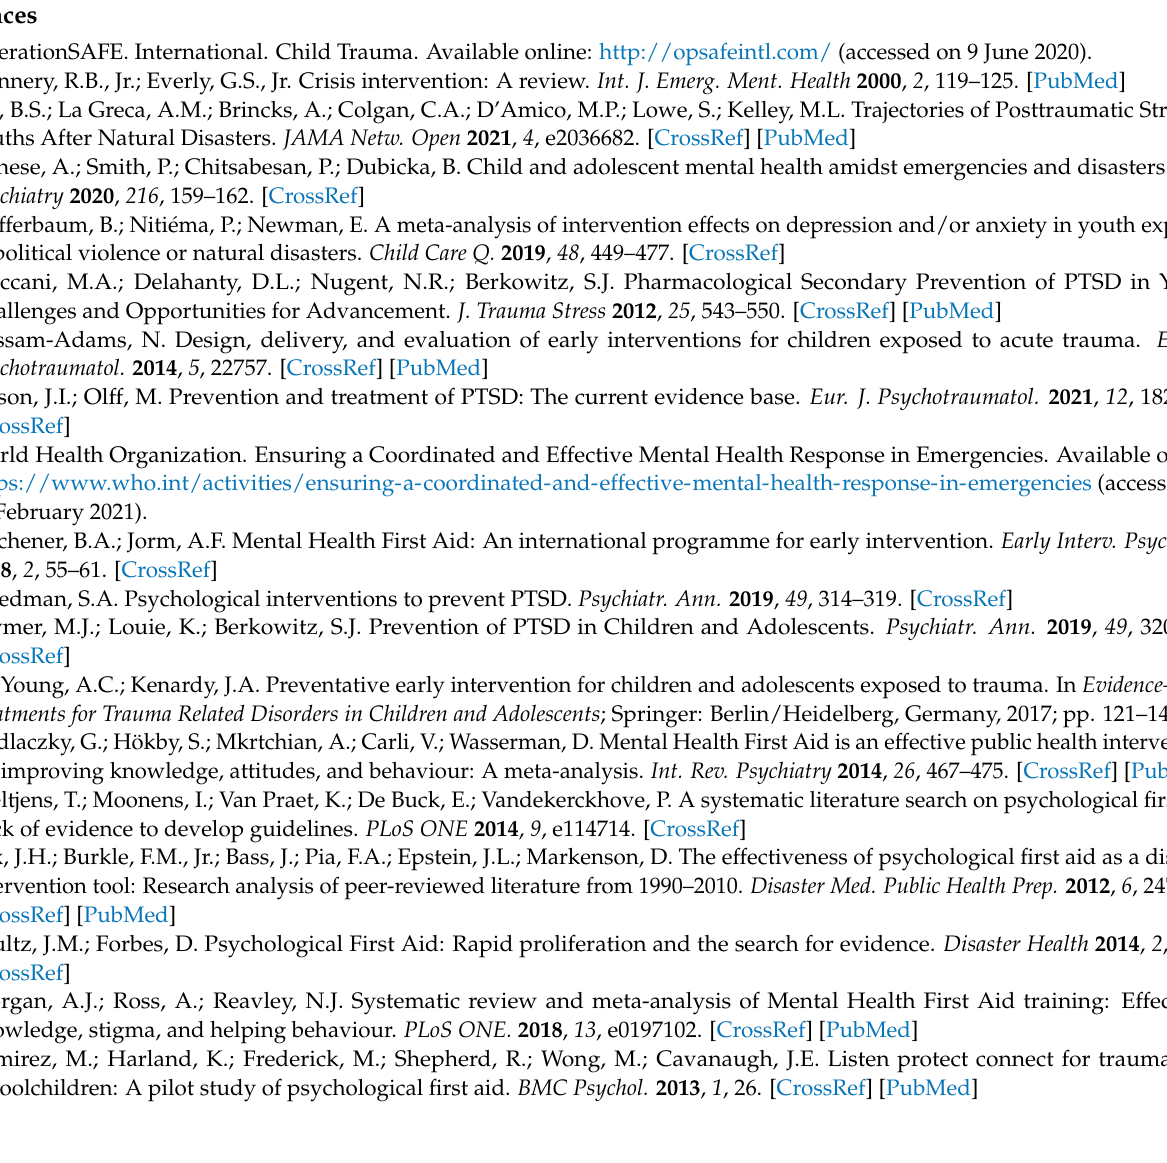
Figure A1. Day 1 and day 5 distribution of each trauma-related symptom score *. * Scores are from data ‘across all subjects from all sites’.